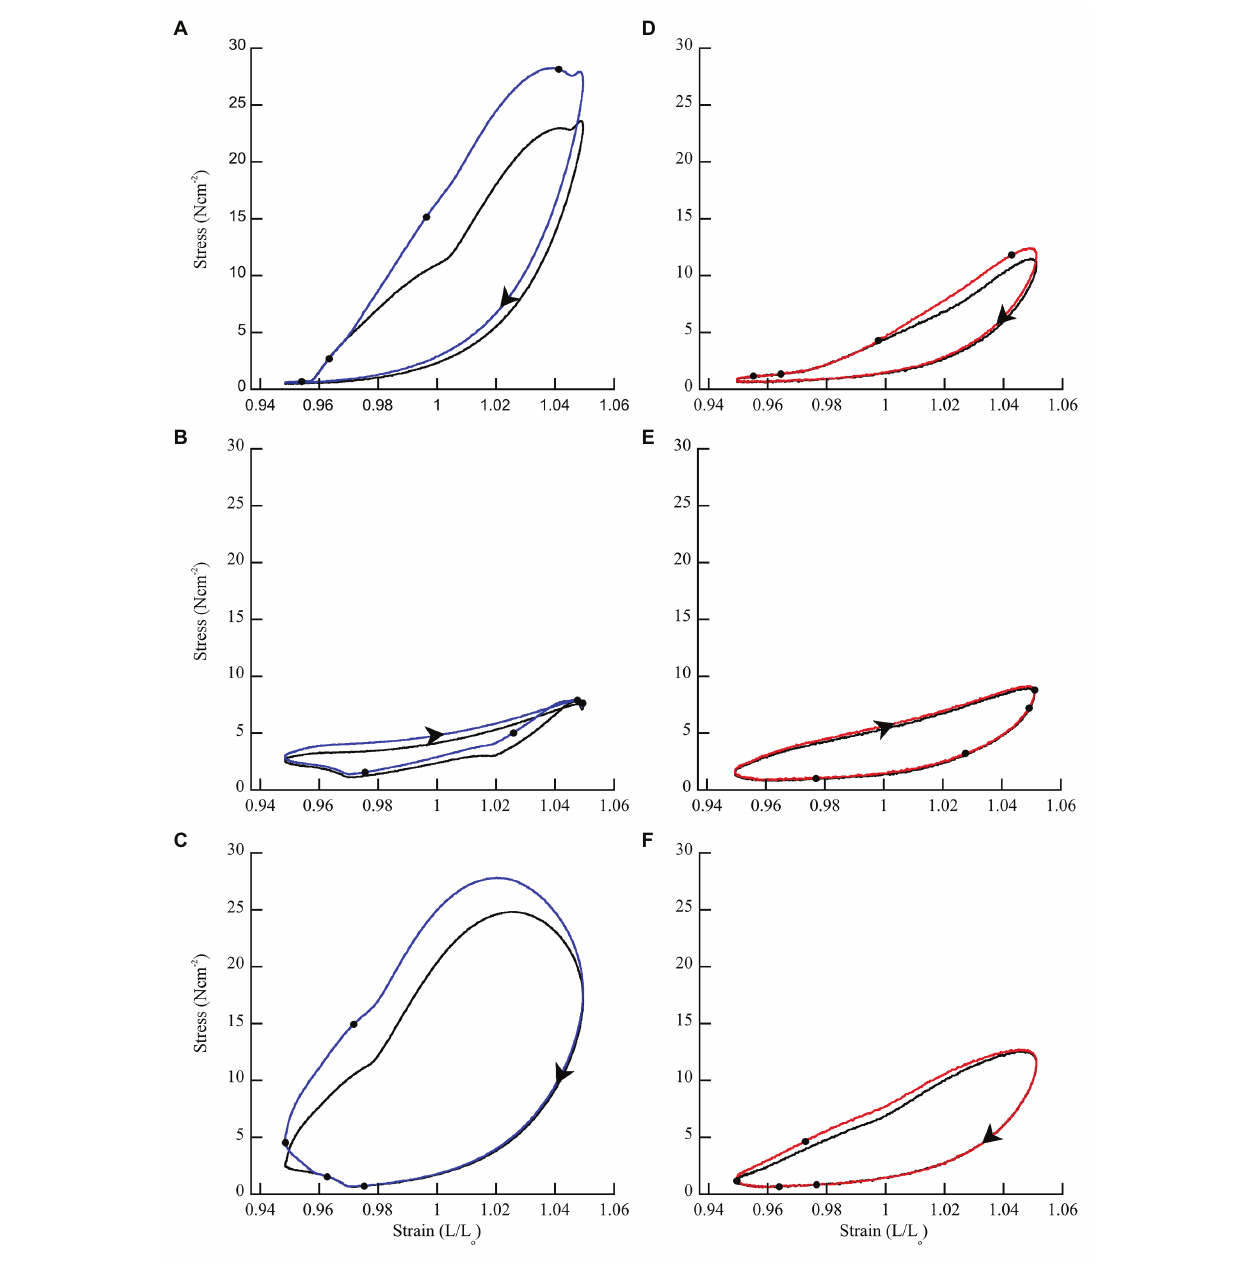
FIGURE 3 | Representative work loops from wild type and mdm soleus muscles stimulated with (blue = wild type; red = mdm ) and without (black) a doublet. (A,D) Phase = 8.3% when the muscle is lengthening. (B,E) Phase = 50% when the muscle is shortening. (C,F) Phase = 83.3% when the muscle is shortening followed by lengthening. The effect of doublet stimulation on work per cycle (area within the work loop) changes with the phase of activation and is greatest when stimulation occurs during lengthening (phase < 50%). Black dots indicate individual stimuli. Arrows indicate the direction of a work